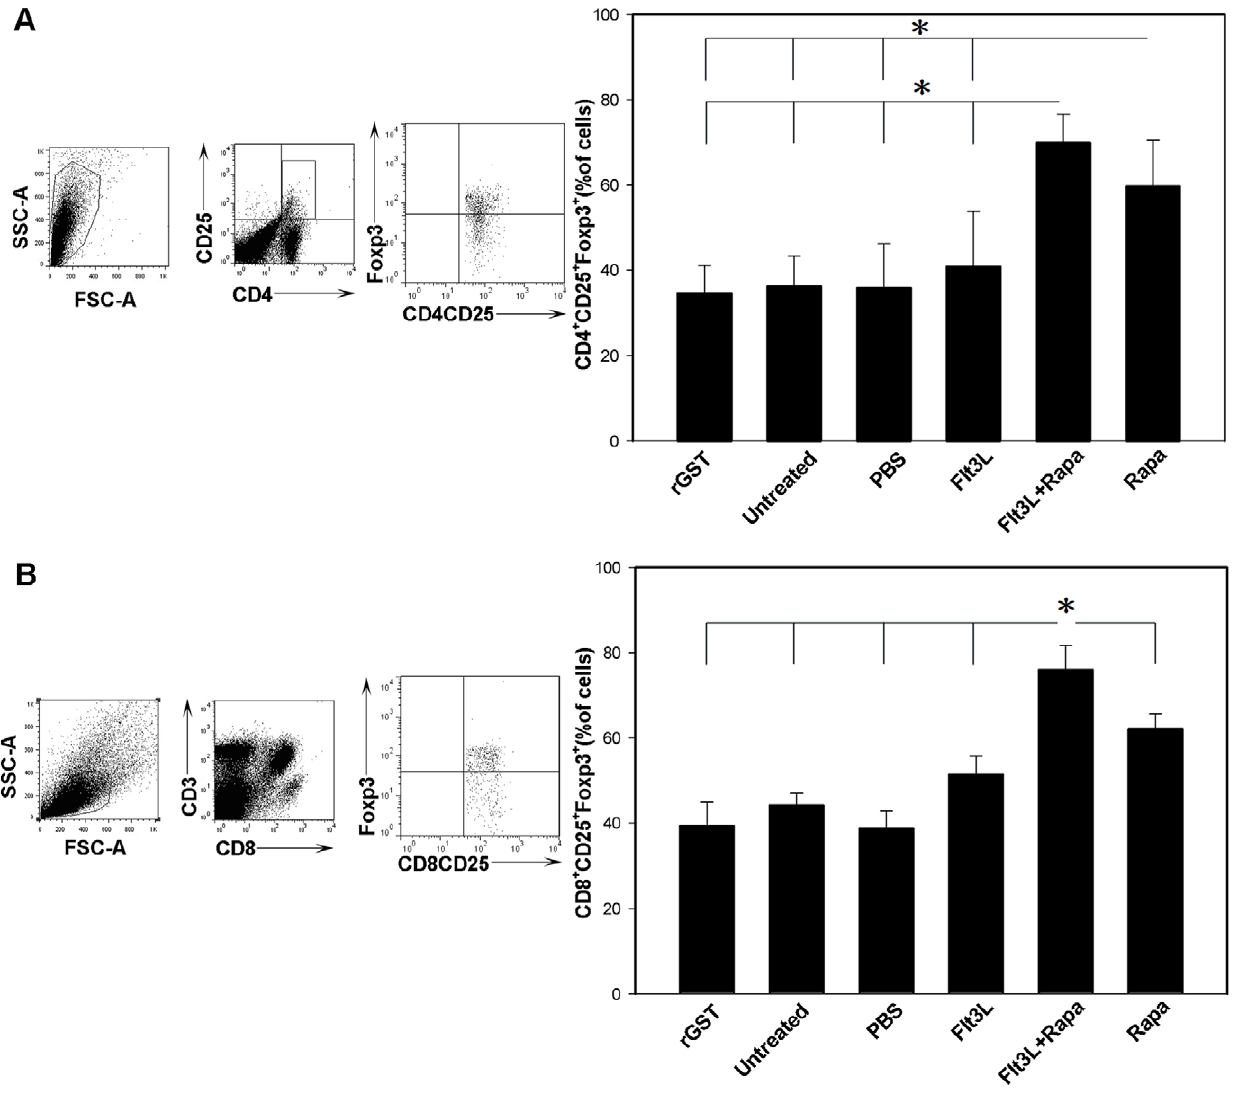
Figure 3. Flt3L combined with Rapa promotes the production of CD4 + CD25 + Foxp3 + and CD8 + CD25 + Foxp3 + T cells. Spleen cells isolated from mice treated with Flt3L/Rapa and other control mice at the time of rejection or at study endpoint (POD 100) were analyzed to determine the proportion of CD4 + CD25 + Foxp3 + and CD8 + CD25 + Foxp3 + T cells. (A, B) The expression of Foxp3 by CD4 + CD25 + and CD8 + CD25 + T cells was analyzed by flow cytometry after intracellular staining. The bar graph was a summary of percentages of CD4 + CD25 + Foxp3 + T cells and CD8 + CD25 + Foxp3 + T cells in the recipients. The data shown are representative of three independent experiments that yielded comparable results (* P ,